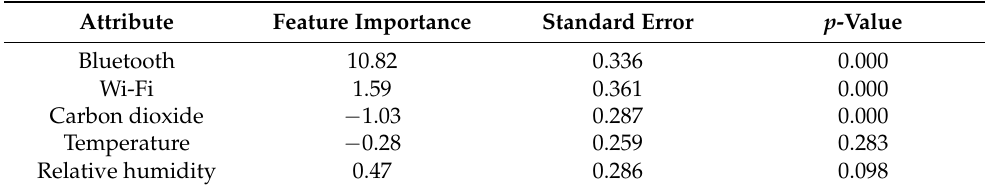
Table 2. Feature importance of sensors using OLS regression.